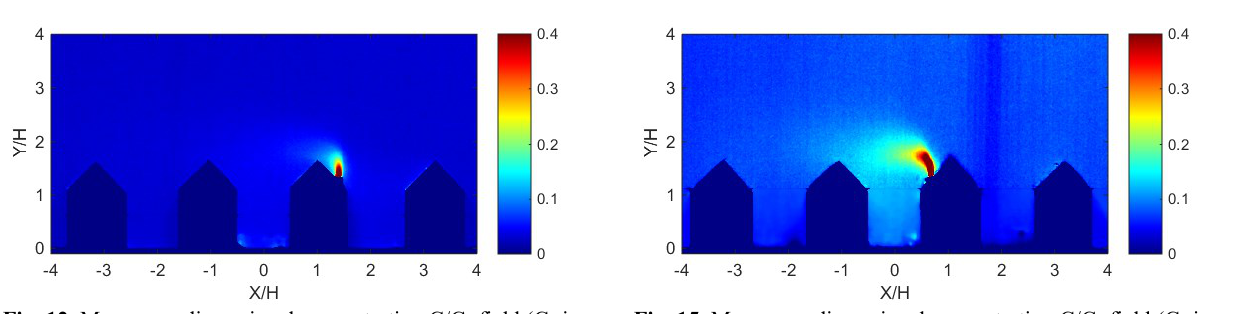
Fig. 12. Mean non- dimensional concentration C/C 0 field (C 0 is the mean concentration measured at the top of the chimneystack) for pitched roof and a chimneystack (on the upstream pitch) with h/H = 0.25; the flow moves from the right to the left.